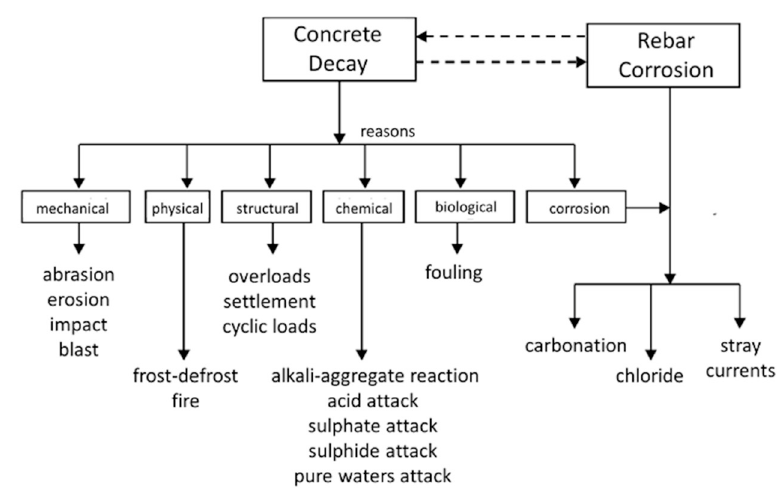
Figure 5. Types of damages occurring on a concrete pillar.